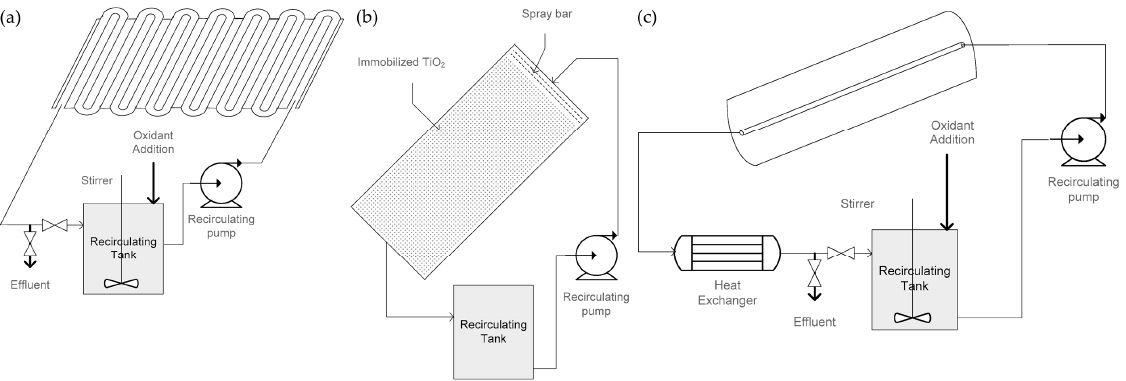
Figure 3. Schematic drawing of: ( a ) slurry CPC (Compound Parabolic Concentrator) system; ( b ) FPR (Flat plate reactor) system; ( c ) PTR (Parabolic Trough reactor) system (Reprinted from Ref. [120]).